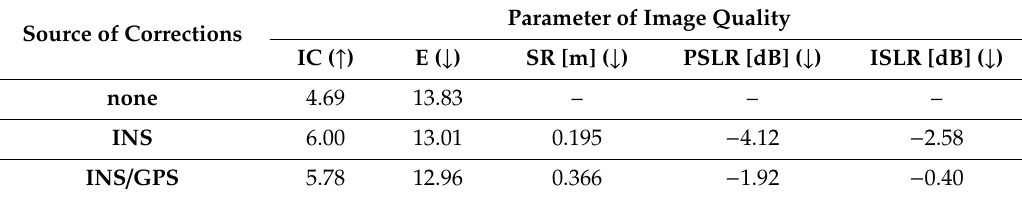
Table 4. Parameters of the quality of the selected SAR image.